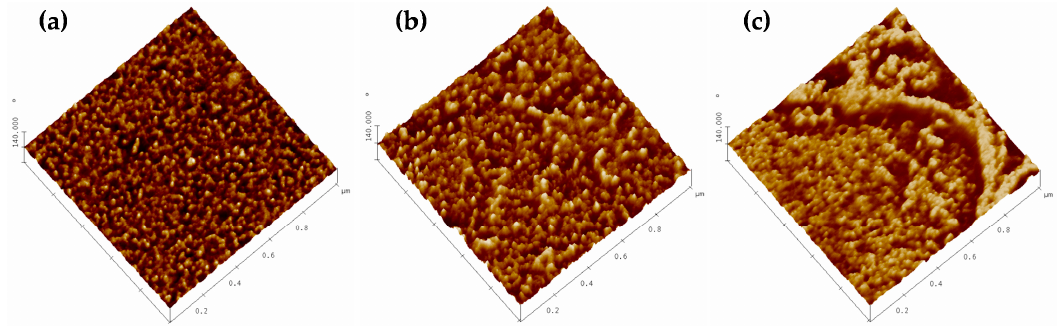
Figure 2. Phase contrast images for 1 × 1 µ m scanned areas of ( a ) HFM-183, ( b ) FM-183 + PSS, and ( c ) HFM-183 + PSS + Ar.